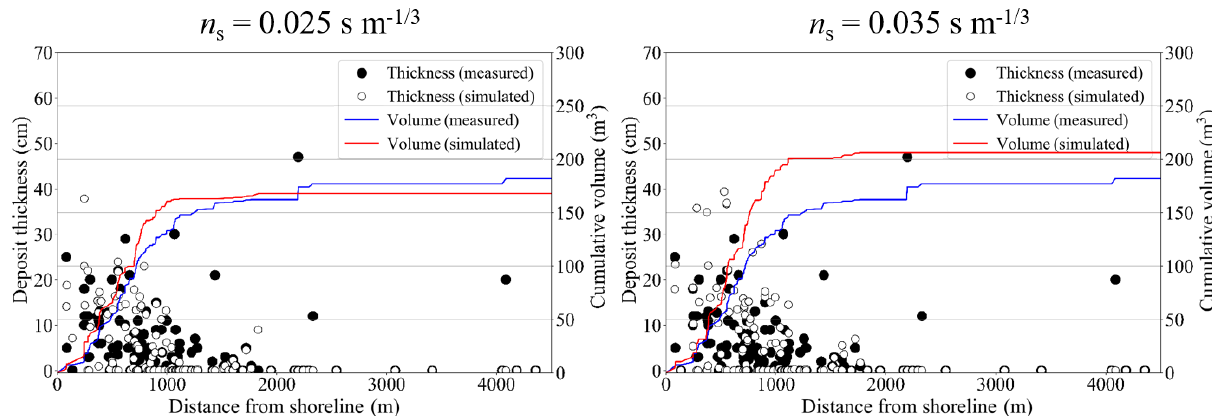
Figure 12. Comparison of field-measured and simulated tsunami deposit thickness for each roughness coefficient.